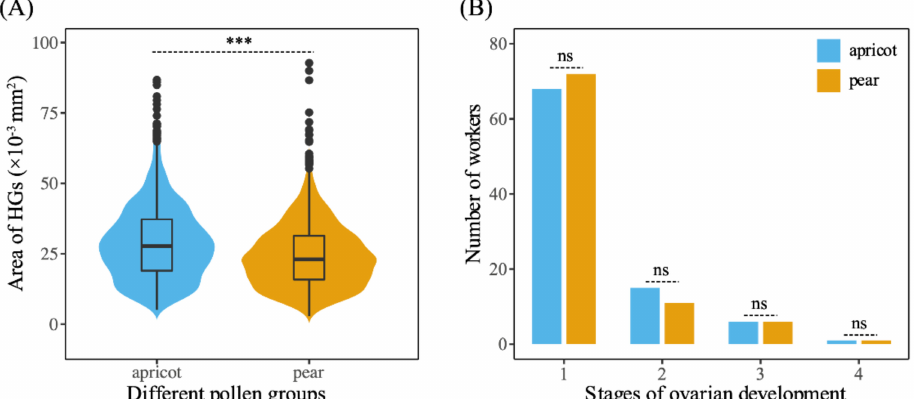
Figure 4. ( A ) Hypopharyngeal gland (HG) development of workers fed apricot pollen and pear pollen diets; ( B ) Ovarian development of workers fed apricot pollen and pear pollen diets. Violin plots showing these results; the violin shape shows the distribution of the values, and there is a box plot inside. The black line in the center indicates the median, the top of the black box represents the upper quartile, the bottom of the black box represents the lower quartile, and the black dots indicate outliers. Asterisks represent the level of significance. *** p < 0.001, ns p >